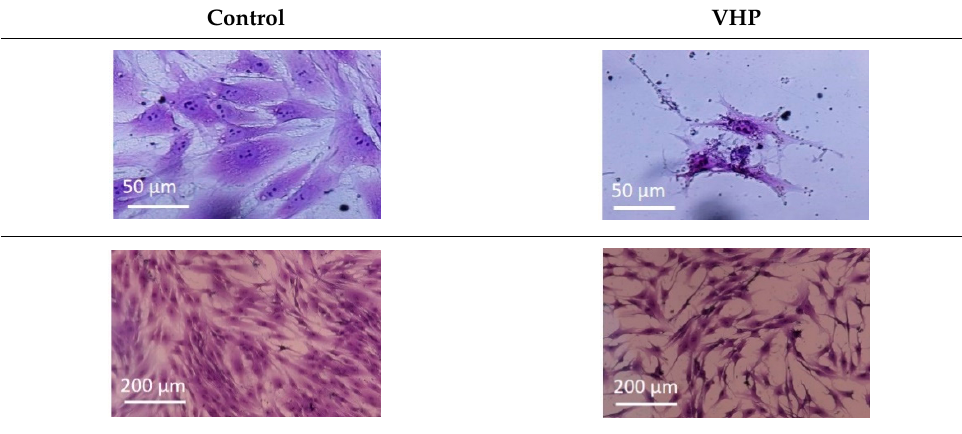
Table 4. Comparative images of the cultures 24 h post-treatment.